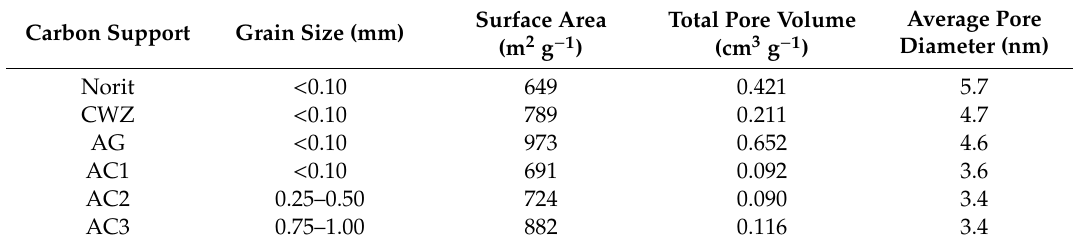
Table 1. Textural properties of carbon